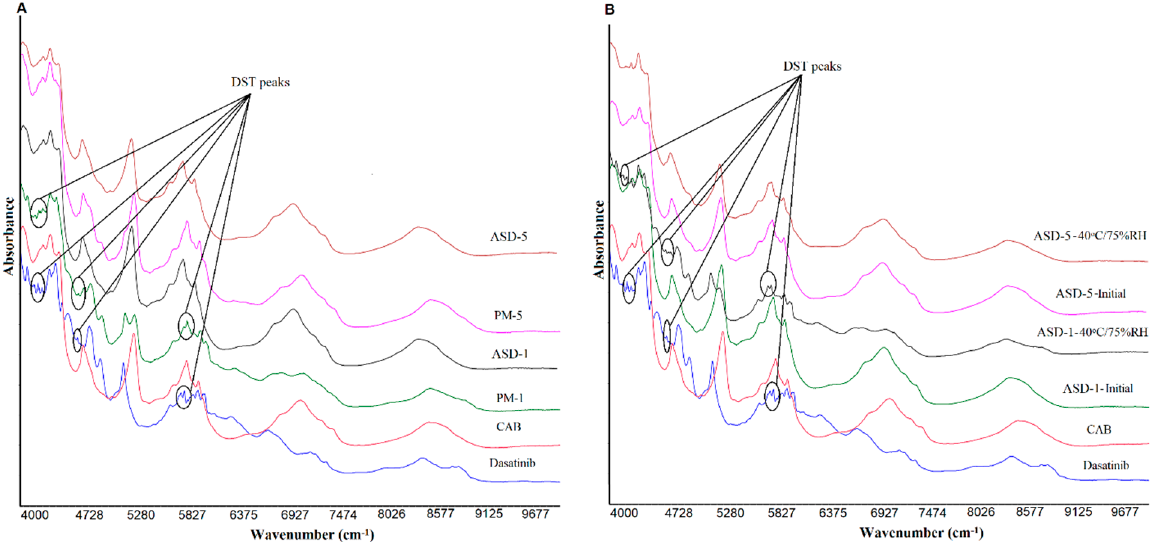
Figure 4. NIR spectra of ( A ) PM − 1, PM − 5 ( B ) ASD − 1, ASD − 5 initial and 40 °C/75% RH